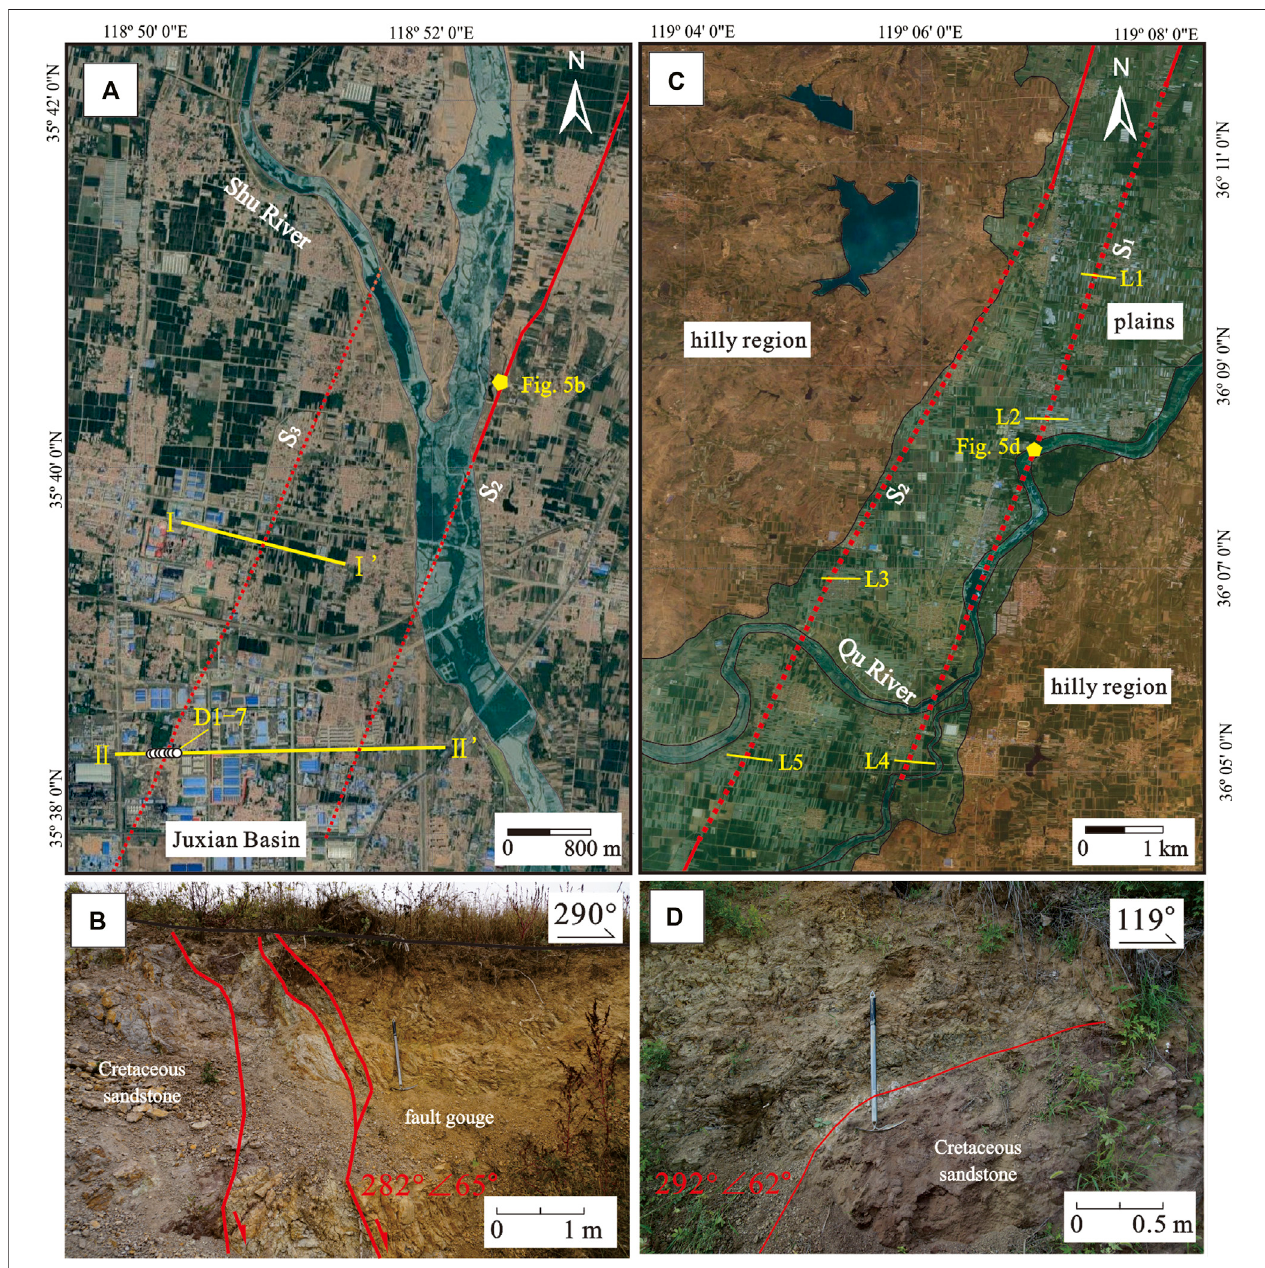
FIGURE 5 | (A) : The locations of the shallow seismic exploration and drilling sites. I-I ′ and II-II ′ indicate shallow seismic test lines. The black circles in section II-II ’ represent boreholes D1-7 (the borehole locations are shown in Figure 6E ). (B) : A fault outcrop next to the shallow seismic survey lines. (C) : Locations of GPR survey lines. (D) : A fault outcrop next to the GPR survey lines. The locations of S1, S2 and S3 are shown in Figure 4